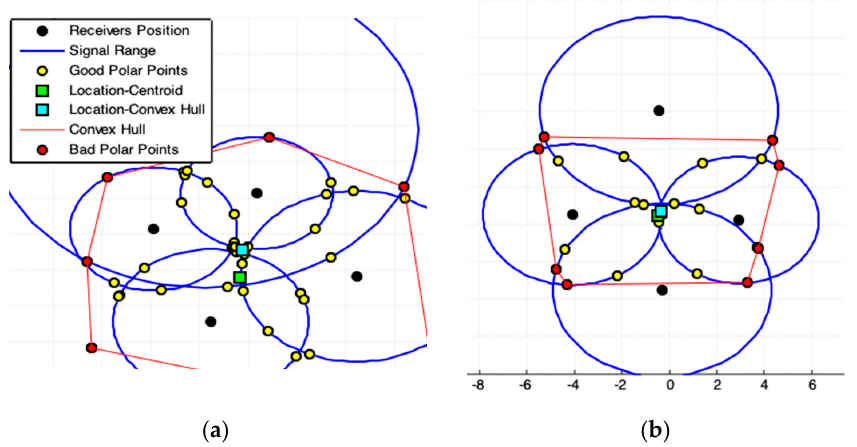
Figure 7. Different cases and respective responses of the PPC and CHC models. ( a ) Five receivers system. The data has some discrepancies. ( b ) Four receivers system. The data has small inconsistencies. For both cases, is better applying the solution provided by Section 2.1.